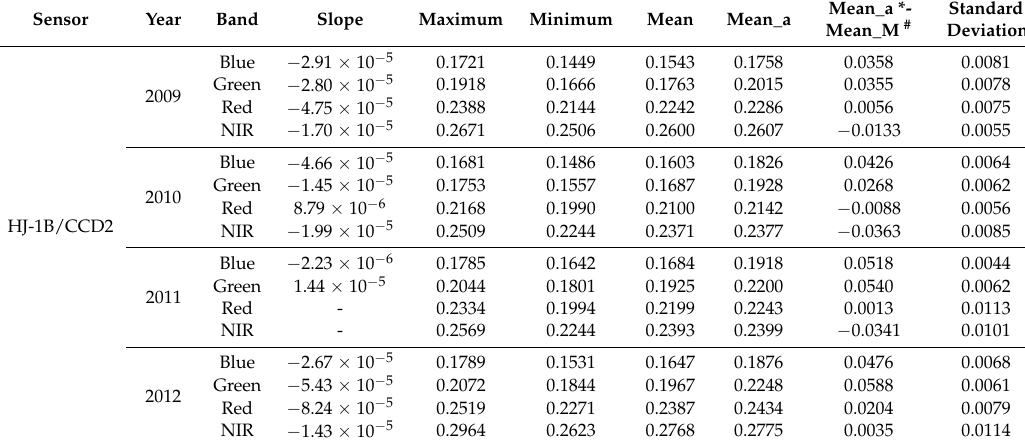
Table 11. The statistics from the time series of the TOA reflectances of HJ-1B/CCD2. Sensor